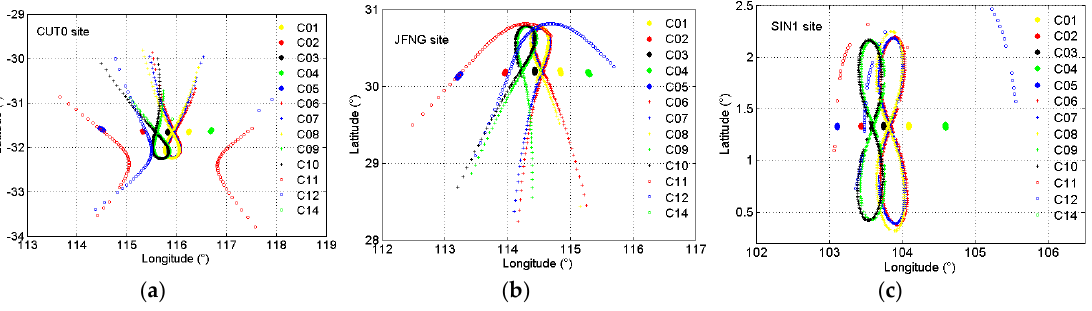
Figure 3. Ionospheric pierce point (IPP) of BDS satellites observed at site CUT0 ( a ), JFNG ( b ), and SIN1 ( c ) on Day 029/2015.